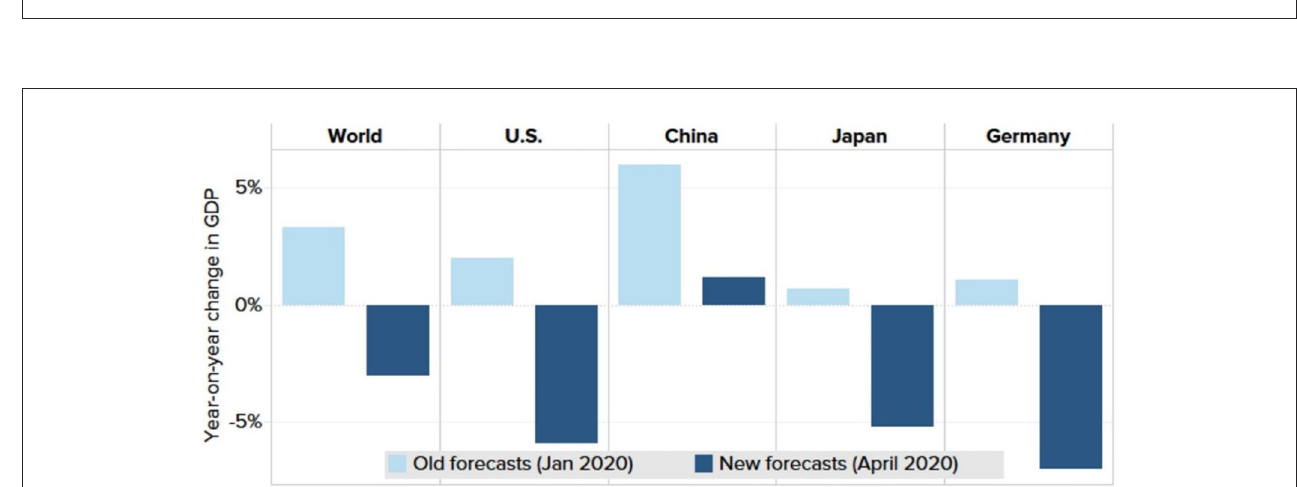
FIGURE12 Economic forecasts (2020). Source: IMF World Economic